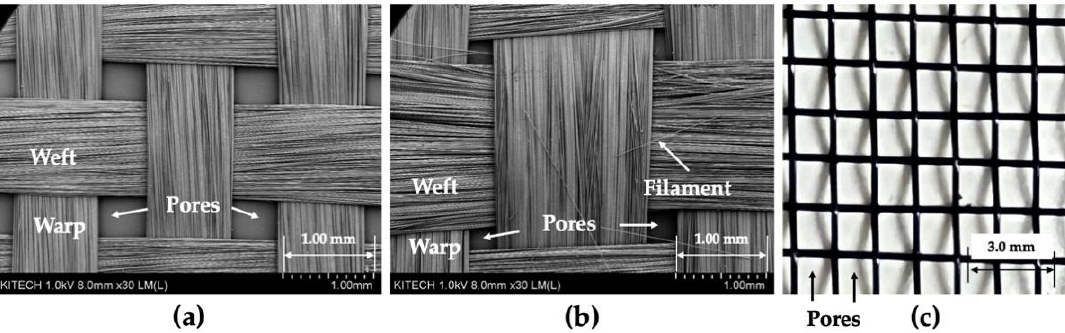
Figure 4. Images of the woven fabric and mesh: ( a ) fabric A (1k); ( b ) fabric B (3k); ( c ) mesh. Table 2. Geometric information of the woven fabrics and mesh.